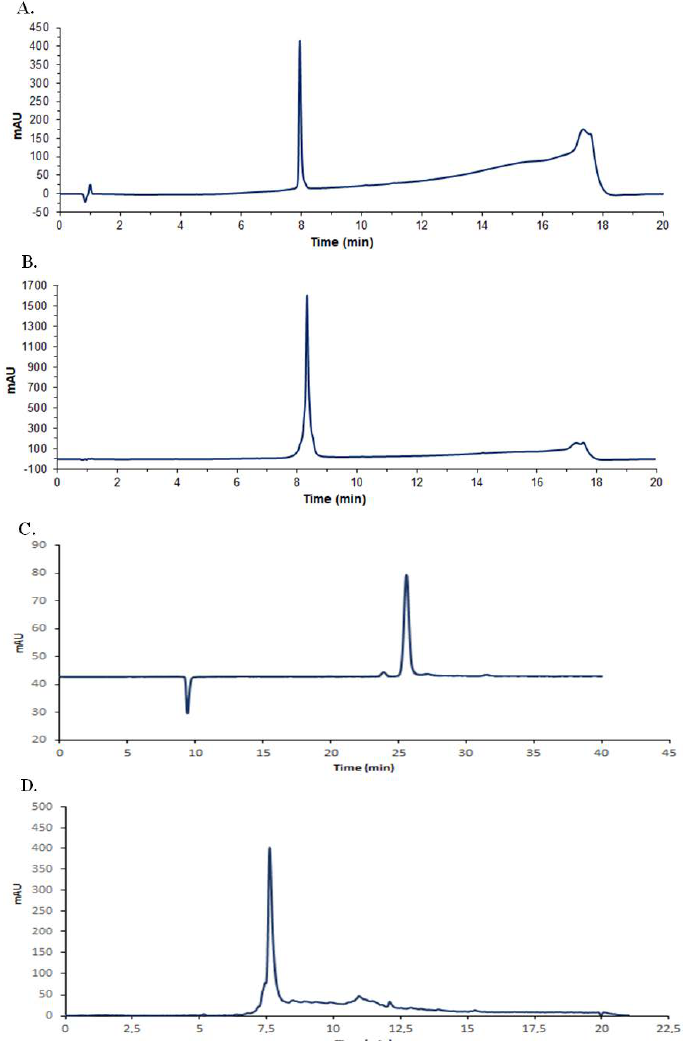
Figure 1. HPLC chromatogram profiles of purified antimicrobials. ( A ), bactofencin; ( B ), pediocin PA-1; ( C ), reuterin and ( D ), nisin, where mAU is the intensity of absorbance.